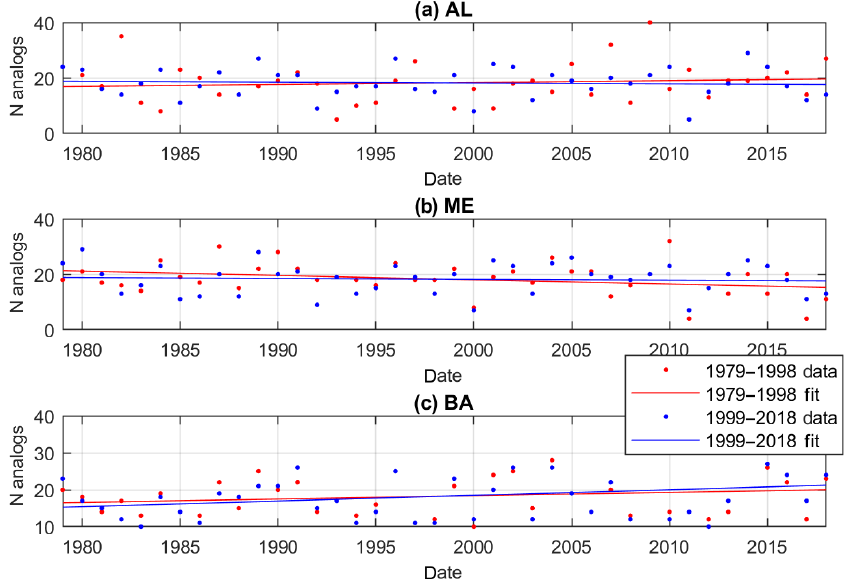
Figure 11. Number of analogs per year of the average sea-level pressure fields during days of yearly maximum snowfall for the periods 1979–1998 and 1999–2018. (a) Albania (AL), (b) Montenegro (ME), (c) Bosnia (BA). Red corresponds to 1979–1998 and blue to 1999–